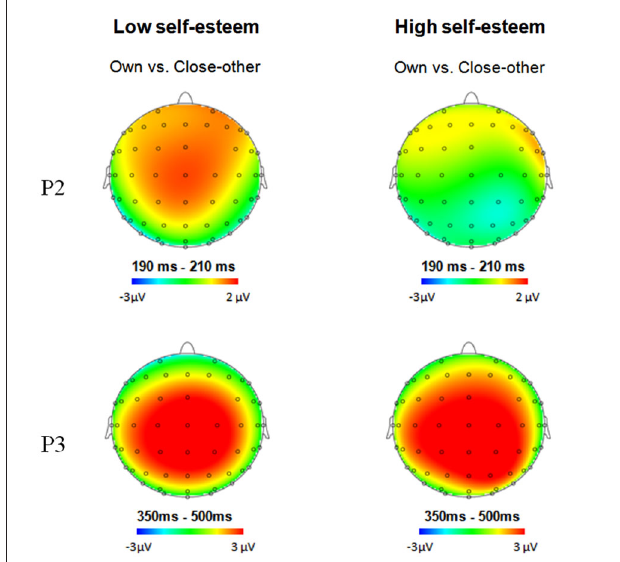
FIGURE 2 | Topographical maps of voltage amplitudes for one’s own name minus close-other’s name difference ERPs at the P2 and P3 components for participants with low self-esteem (left panels) and high self-esteem (right panels).